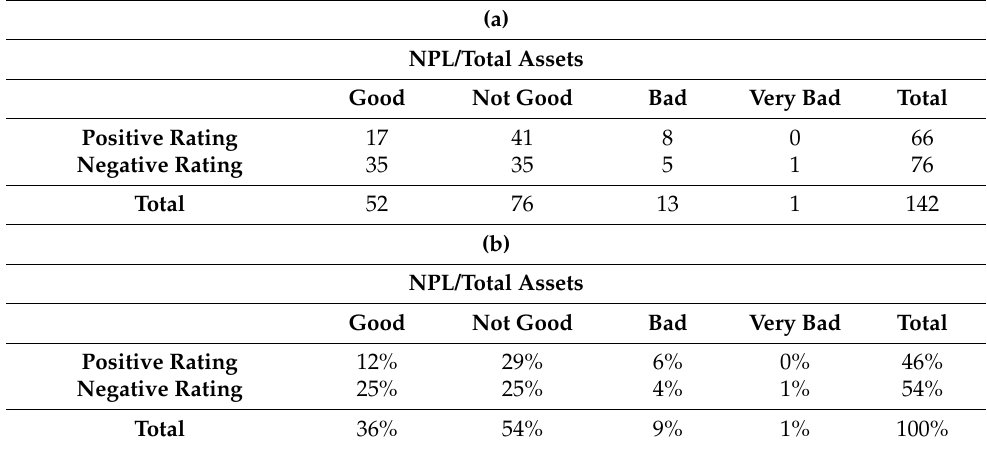
Table 5. Clustering banks according to BTIR and NPLs based on gross loans evidence (own computa- tion): ( a ) results of the clustering in terms of absolute values, and ( b ) results of the clustering in terms of percentages composing the